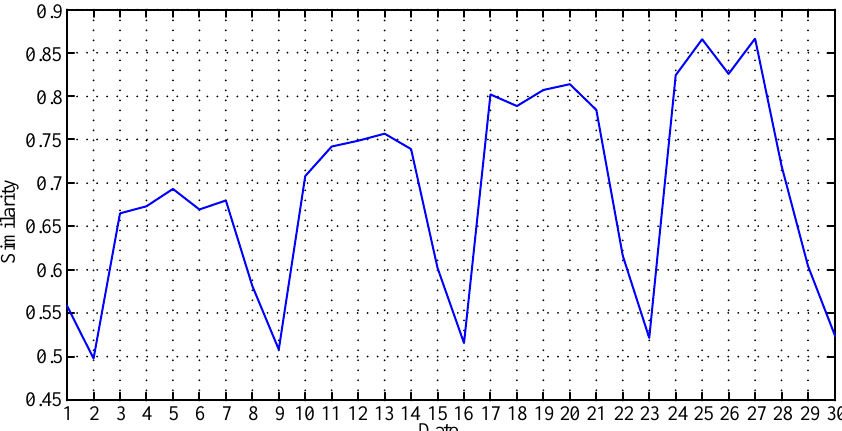
Figure 2. Similarity curve among historical days and predictive day.